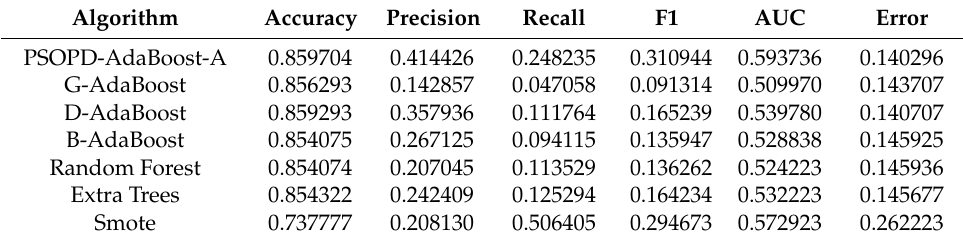
Table 4. Comparison of Classification Results on the PC3 Dataset.